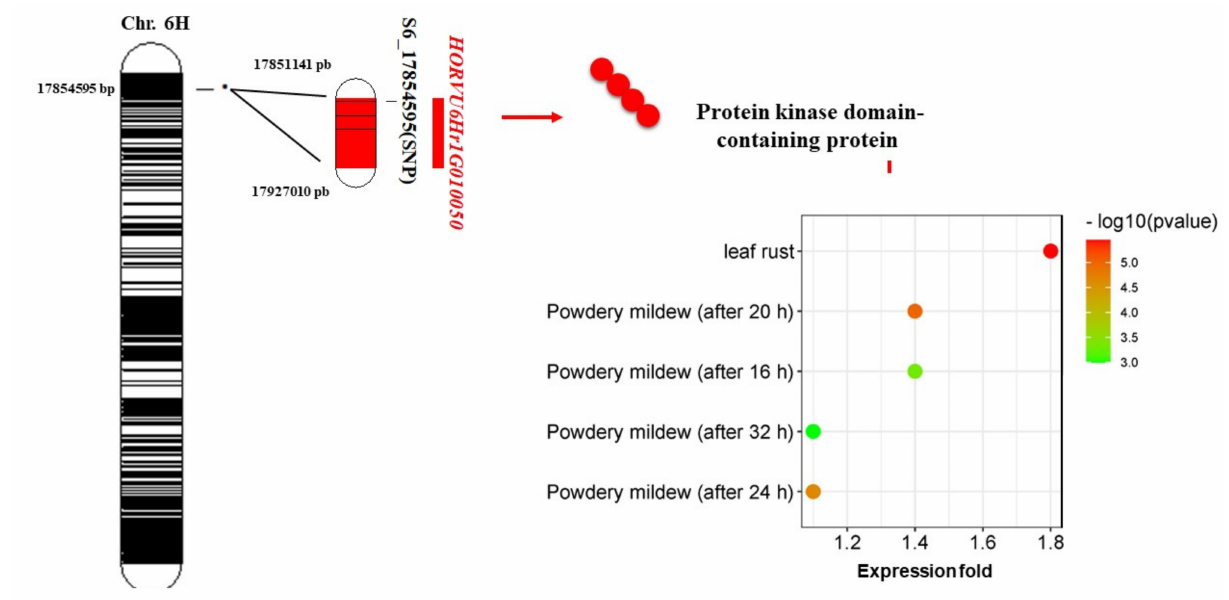
Figure 4. Position and candidate gene with its annotation for S6_17854595 SNP associated with loose smut